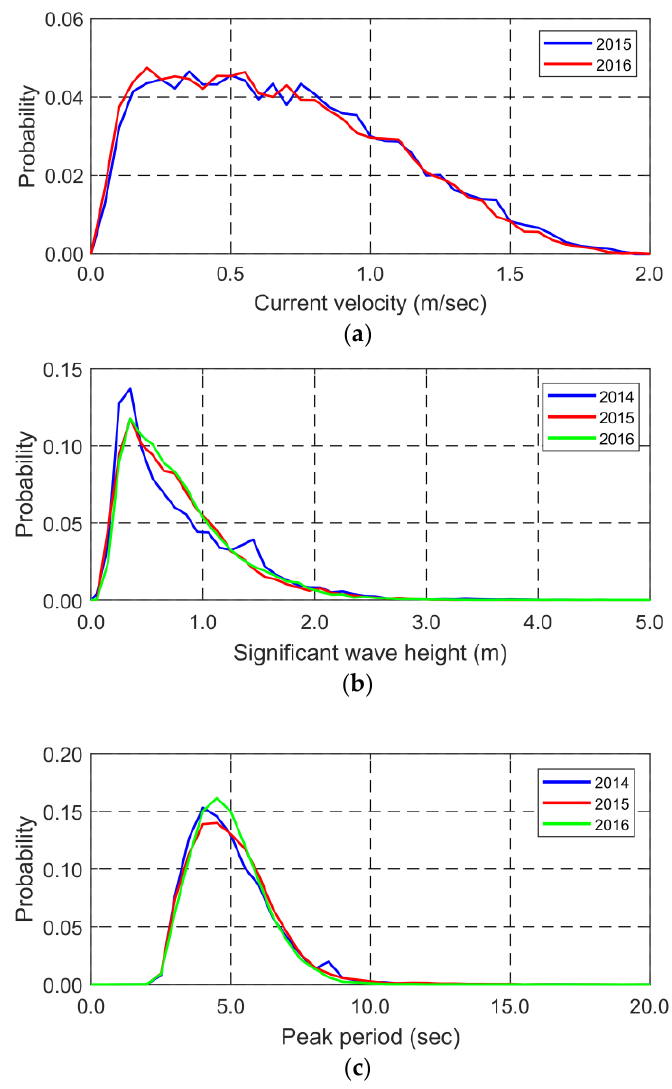
Figure 2. Measured current velocity ( a ) significant wave height ( b ), and peak period ( c ) of southwest coast of South Korea in years of 2014 – 2016.